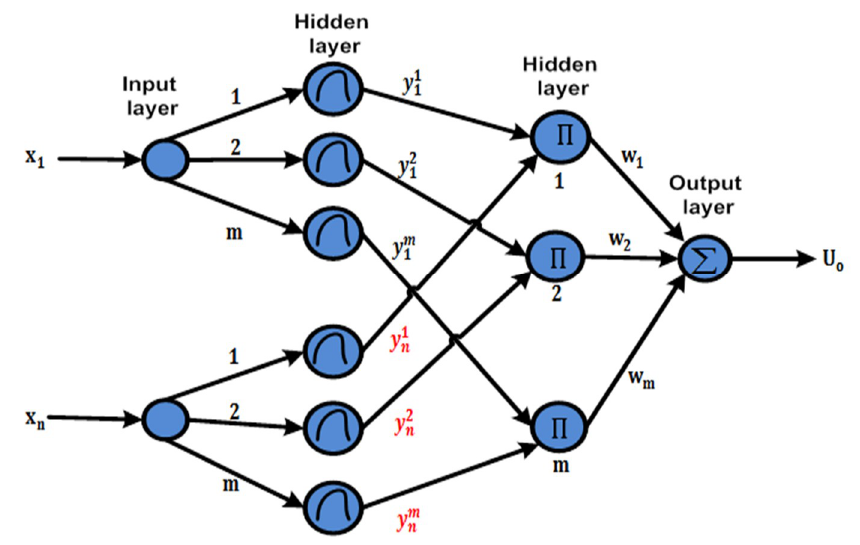
Figure 3. Structure of the Fuzzy Neural Network (FNN).